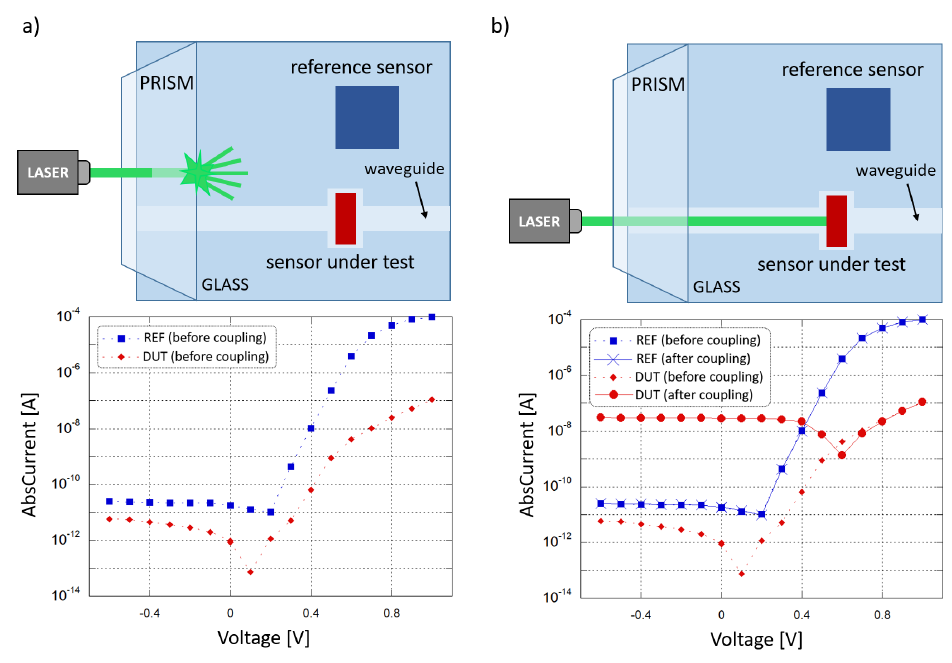
Figure 9. Optical coupling test. ( a ) Laser beam not aligned to the DUT waveguide (scenario depicted at the top): current-voltage behavior of the two sensors (plotted at the bottom). ( b ) Laser beam aligned to the DUT waveguide (scenario depicted at the top) current-voltage behavior of the two sensors (plotted at the